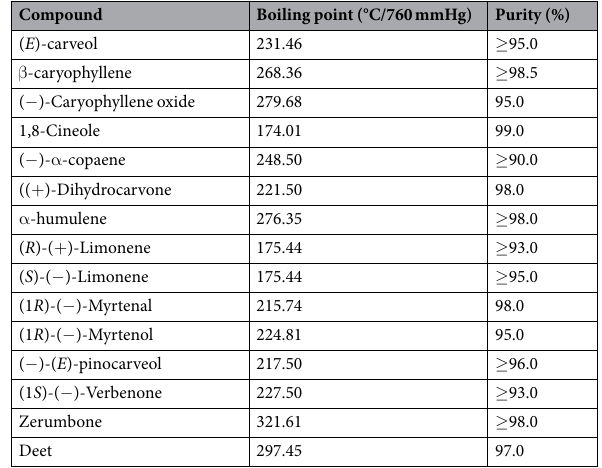
Table 6. Boiling points of 14 pure organic compounds and commercial repellent deet tested for